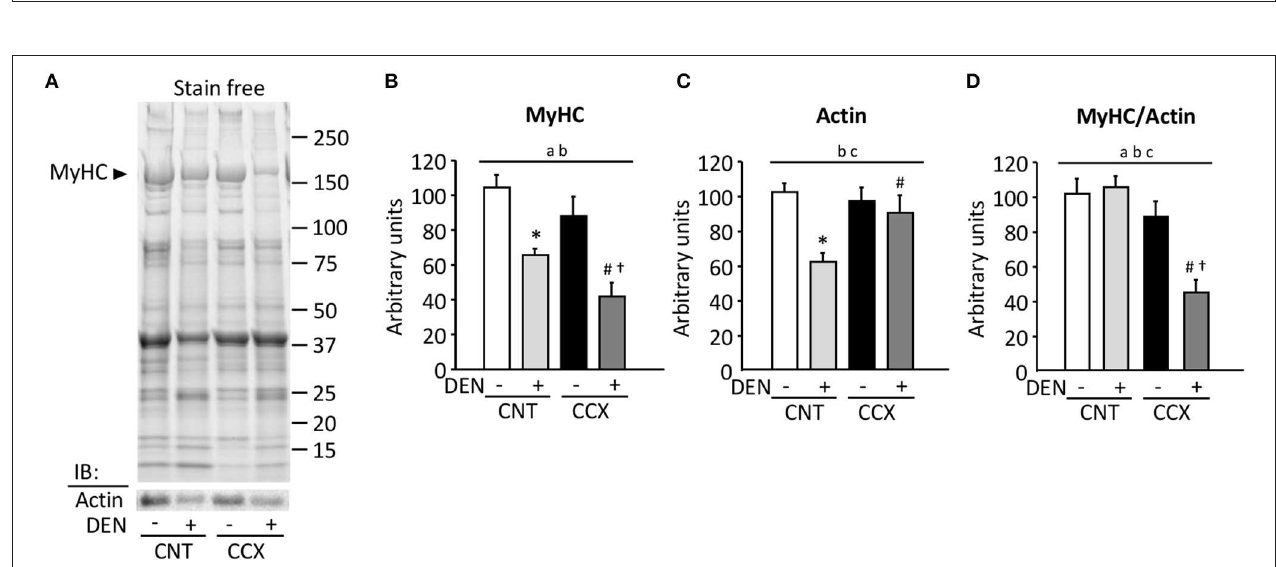
FIGURE 2 | Cancer cachexia induces preferential loss of myosin in denervated mouse gastrocnemius muscles. Representative stain free images of whole muscle proteins and immunoblots for actin in gastrocnemius muscles from control (CNT) and cancer cachexia (CCX) mice, with or without denervation (DEN) (A) . Myosin heavy chain (MyHC) (B) and actin (C) content was normalized by total muscle proteins. The ratio of MyHC to actin (D) . Bars show the mean and SEM results from 5 to 6 muscles per group. Statistical significance was set at P < 0.05: main effect of a CCX and b DEN; c interaction of CCX and DEN; difference vs. *CNT without DEN, # CNT with DEN, and † CCX without